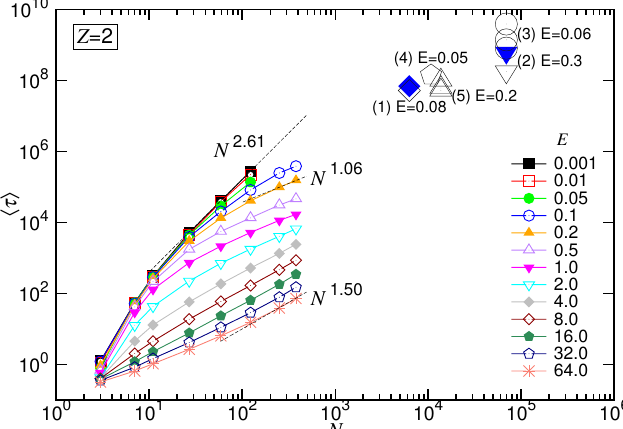
Figure 15. Comparison of the experimental results with the simulations. The experimental data are taken from (1) [85] (diamonds), (2) [86] (inverted triangles), (3) [82] (circles), (4) [105] (pentagons) and (5) [106] (triangles). The big blue solid symbols indicate that the translocation was done in the presence of divalent salt, while the big open symbols indicate that the data were acquired in the monovalent salt solutions. The strength of the transmembrane field is given near the data points. The conversion of the experimental data into our simulation units can be found in the Supplemental